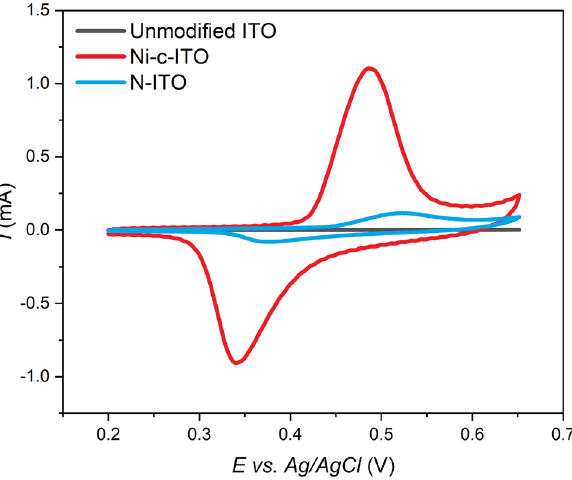
Figure 5. Cyclic voltammograms of unmodified ITO glass (black curve), Ni-ITO (blue curve), and Ni-c-ITO (red curve) in the presence of 5 × 10 –6 mol dm −3 insulin in 0.1 mol dm −3 NaOH and PBS at 50 mV s −1 .